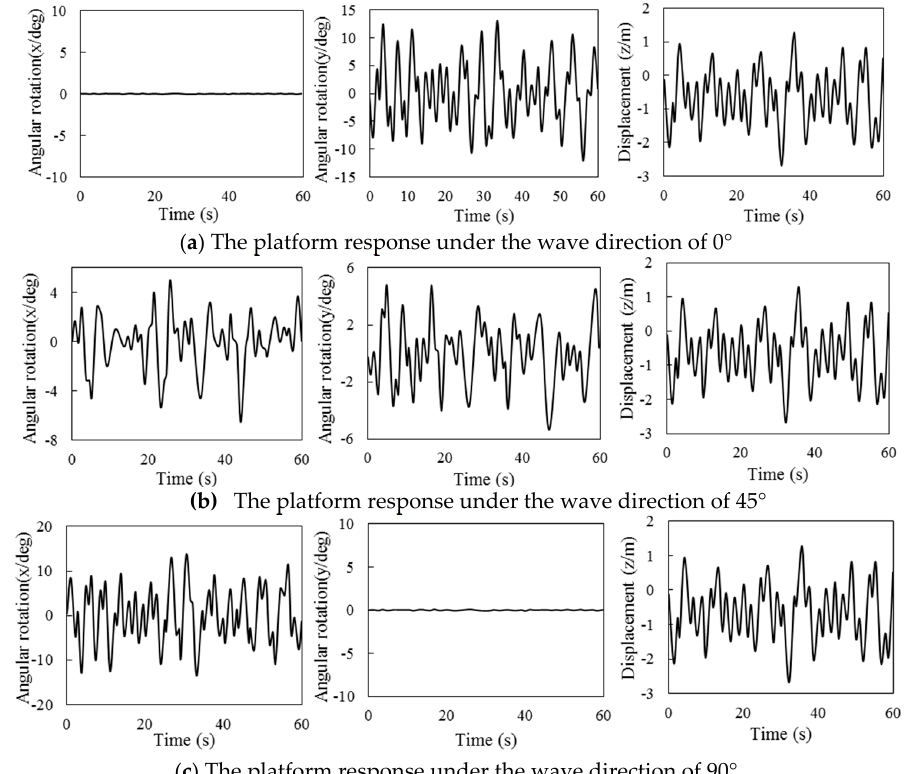
Figure 13. The platform response under wind − sea scale 5 with different wave directions.